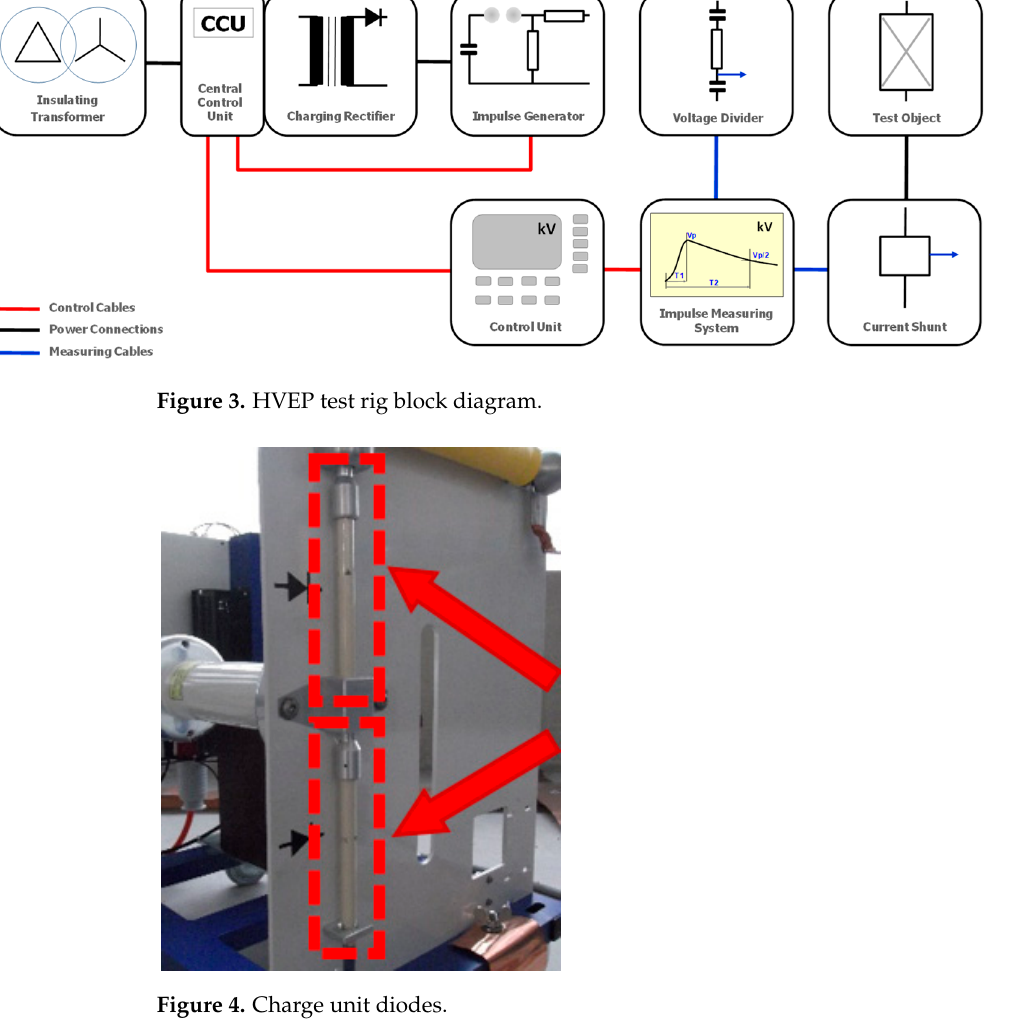
Figure 4. Charge unit diodes.